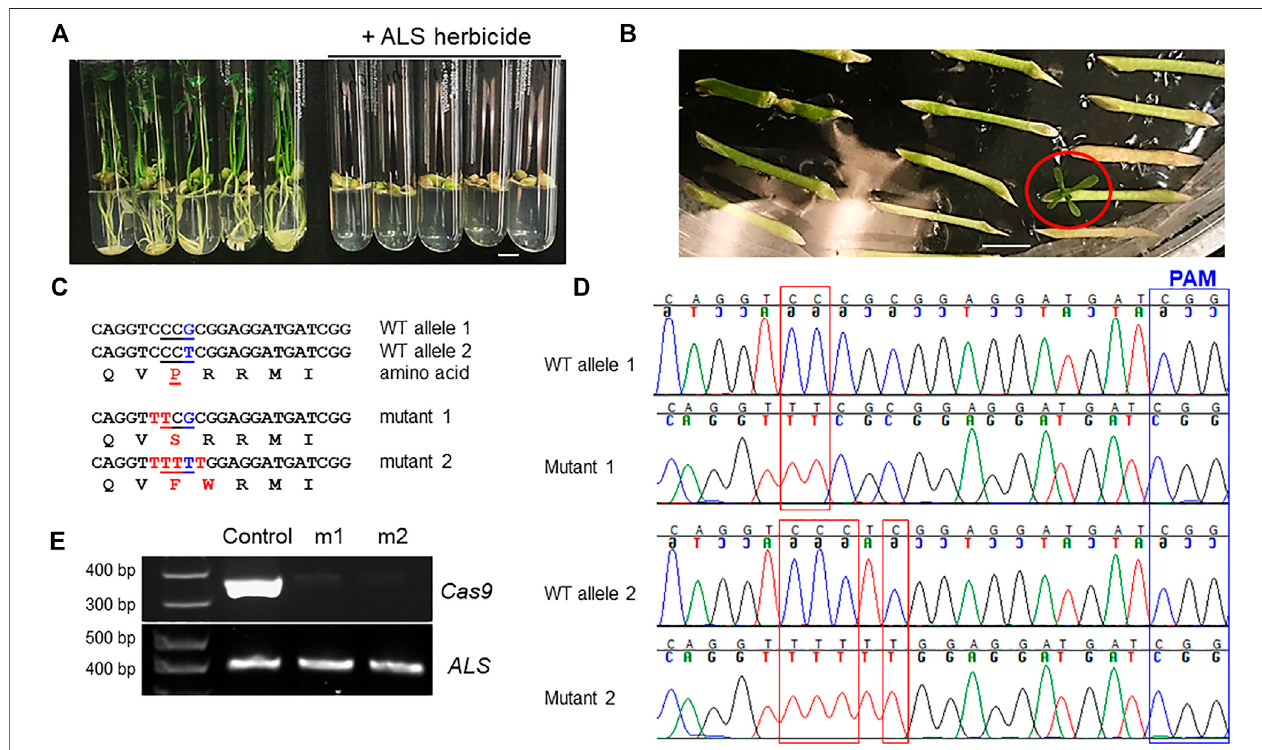
FIGURE 4 | Transgene-free editing of the ALS gene in citrus confers herbicide resistance. (A) The growth of citrus seedlings (Carrizo citrange) was inhibited by the herbicide chlorsulfuron (300 nM). Scale bar, 1 cm. (B) Selection of herbicide-resistant Carrizo citrange on chlorsulfuron-containing media (150 nM). The chlorsulfuron- resistantregeneratedplantwasindicatedbyaredcircle.Scalebar,1 cm. (C) Sequencingresultsfromchlorsulfuron-resistantmutantplants.Theaminoacidsarealigned under the corresponding DNA sequences. Edited sites, in red font. (D) Chromatograms for (C) . Mutation sites are indicated within red rectangles. Sanger sequencing results of the PCR amplicons that were cloned for colony sequencing. For each mutant plant, 14 clones were subjected to Sanger sequencing. (E) PCR of Cas9 and ALS for control plant (GFP positive) and herbicide chlorsulfuron-resistant citrus plants.